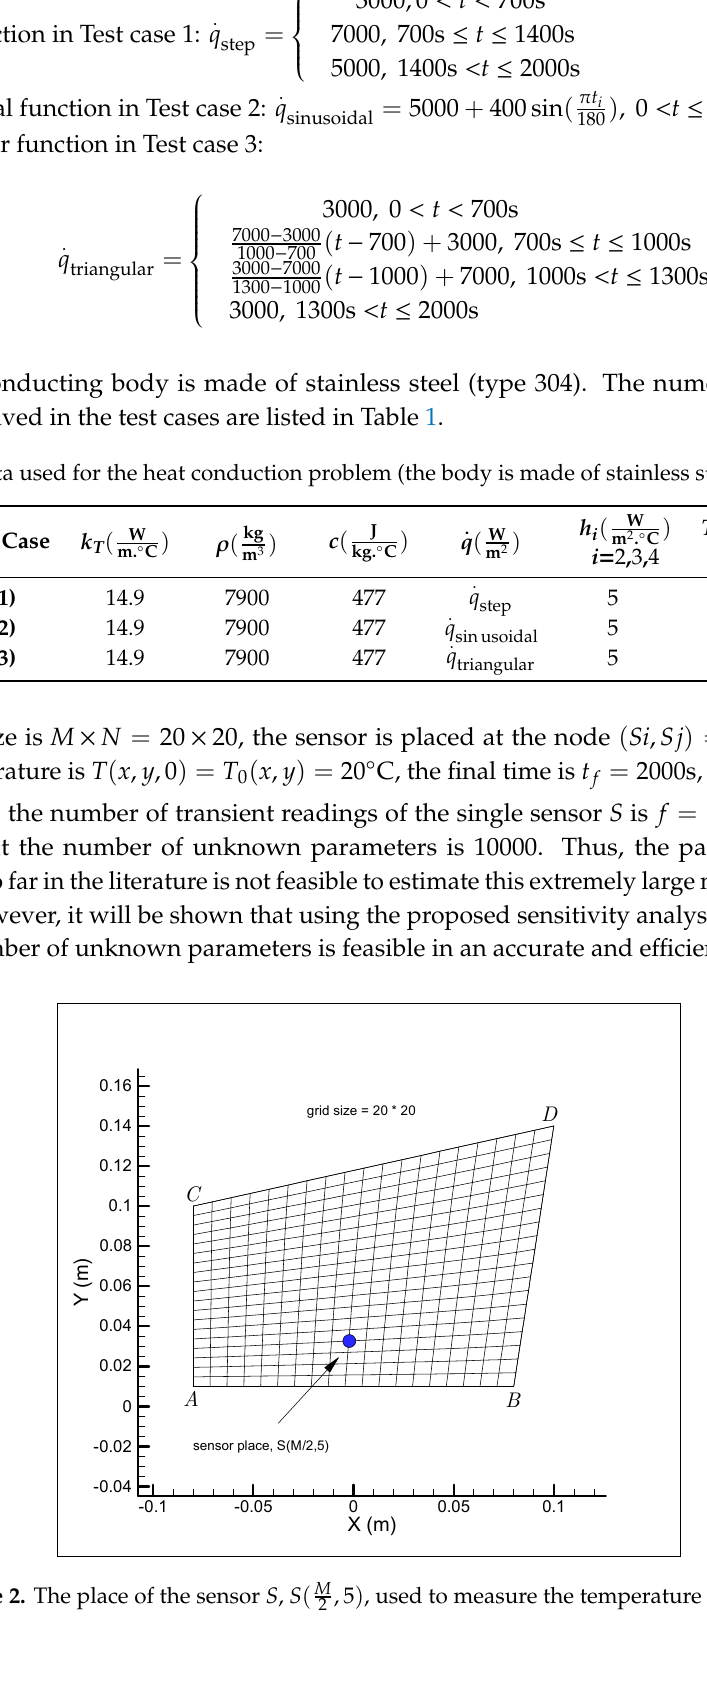
Figure 2. The place of the sensor S ,